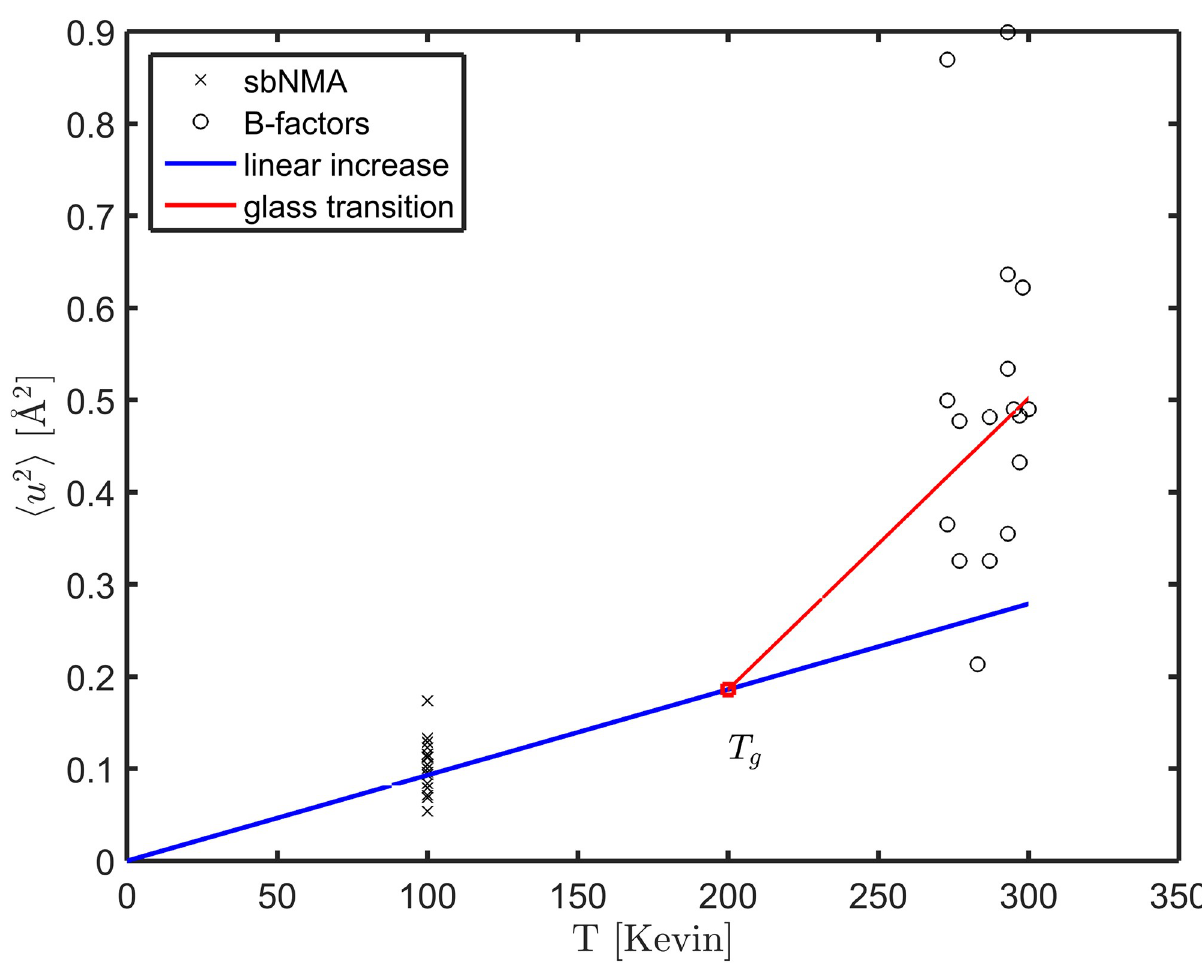
Fig 5. The magnitude of thermal fluctuations as a function of temperature. T g denotes the temperature of glass transition that is 200-220K [38]. The magnitudes computed from sbNMA at 100K are marked by black crosses, while the magnitudes obtained from B-factors by black circles. The blue line represents the universal trend of the magnitude of harmonic vibrations by sbNMA with CHARMM force field, having a nearly universal value around 0.093 Å 2 at 100 K for all proteins [32], and 0.279 Å 2 at 300 K. At above T , anharmonic motions kick in and the magnitude of total thermal fluctuations g increases superlinearly, as marked by the red line that is fitted to the black